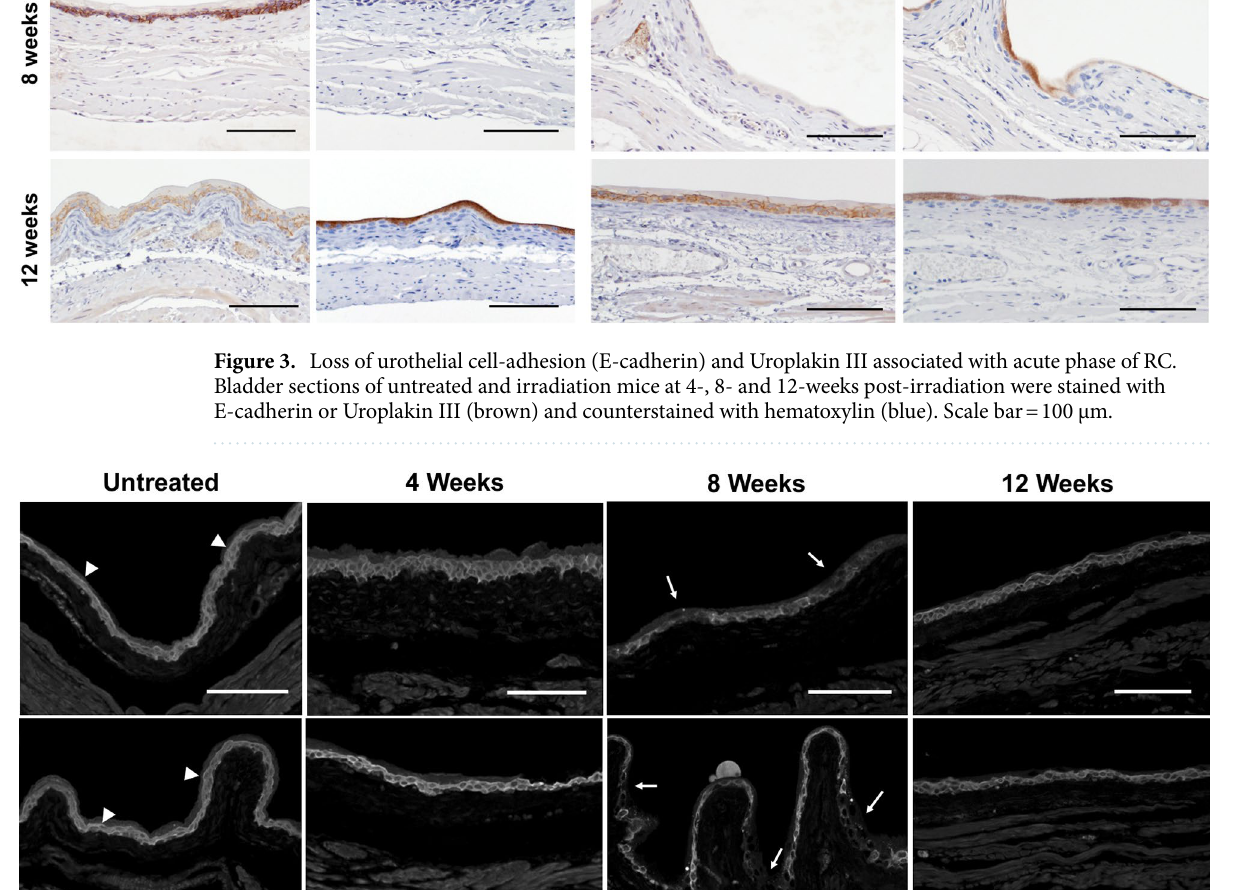
tion resulted in an increase in E-cadherin expression between 3 and 30 days post-irradiation when compared